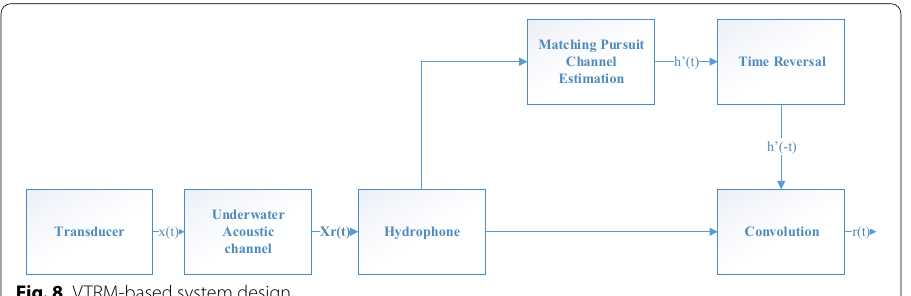
Fig. 8 VTRM-based system